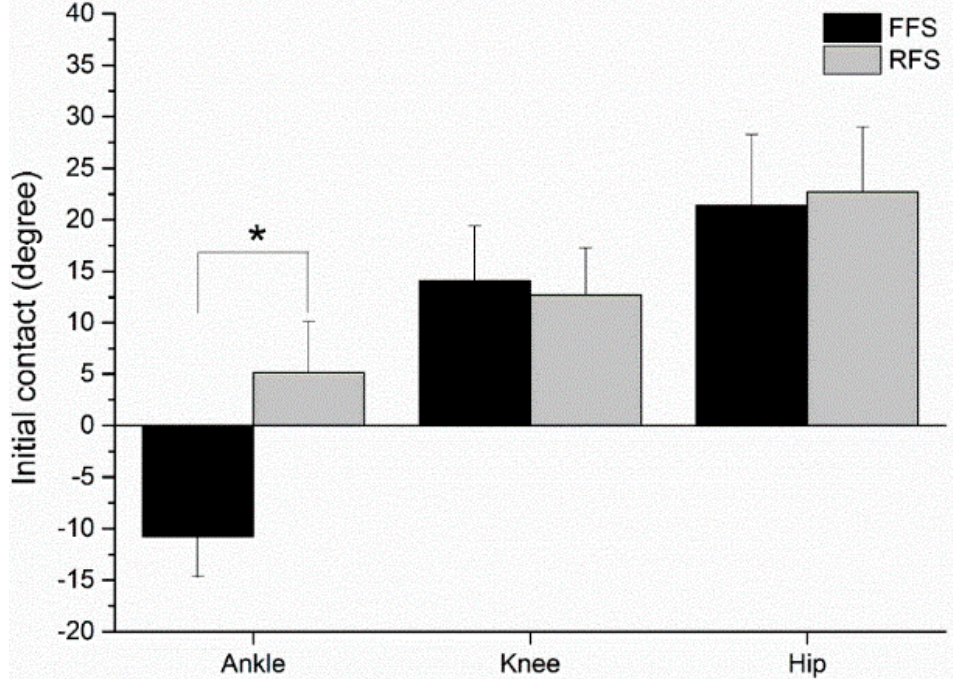
Figure 3. FFS and RFS patterns of sagittal plane at initial contact. Note: * indicate p < 0.05; FFS = forefoot strike pattern; RFS = rearfoot strike pattern; negative values ( − ) indicate ankle plantar flexion; positive values (+) indicate ankle dorsiflexion.